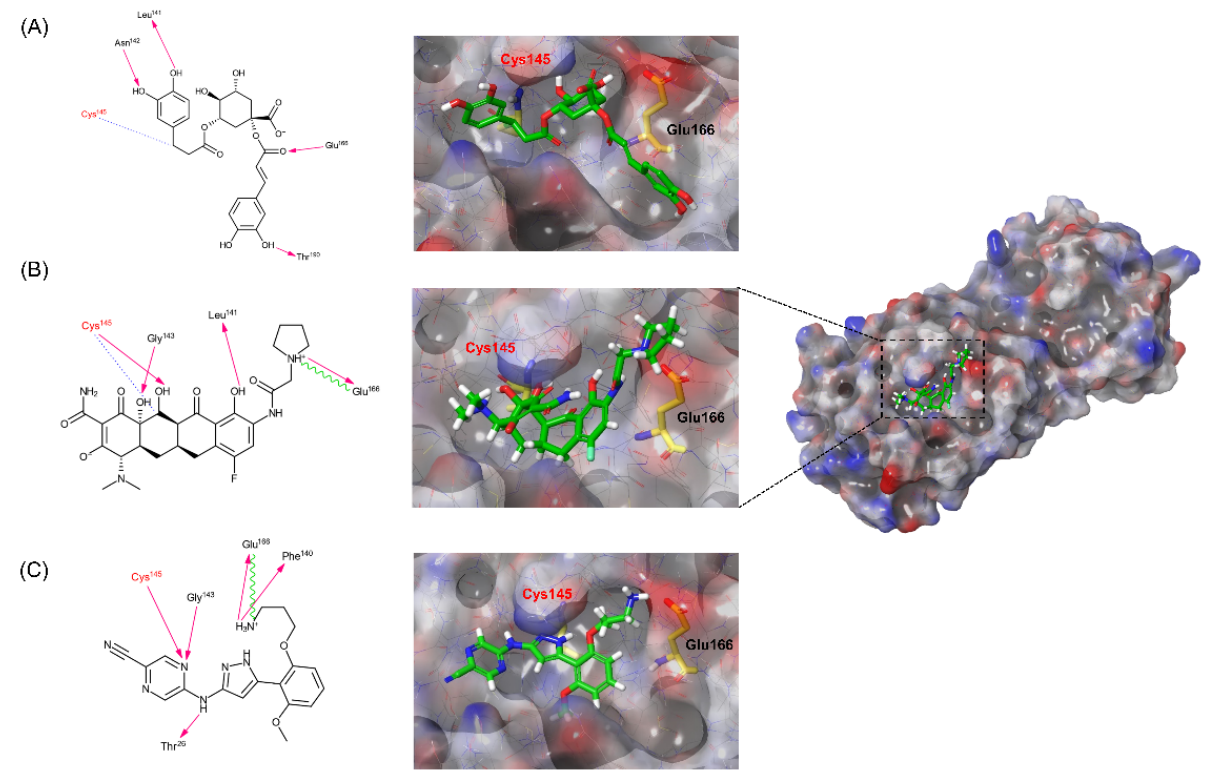
Figure 4. A 2D schematic representation of the interactions between and schematic representations of cynarine ( A ), eravacycline ( B ), and prexasertib ( C ) docked on the catalytic cavity of SARS-CoV-2 3CLpro. The pink arrows represent hydrogen bonds, the blue dot line represents the covalent bond, and the green line represents a salt bridge. The electrostatic surface potential of SARS-CoV-2 3CLpro docked with compounds is depicted (red, negative; blue, positive; white,